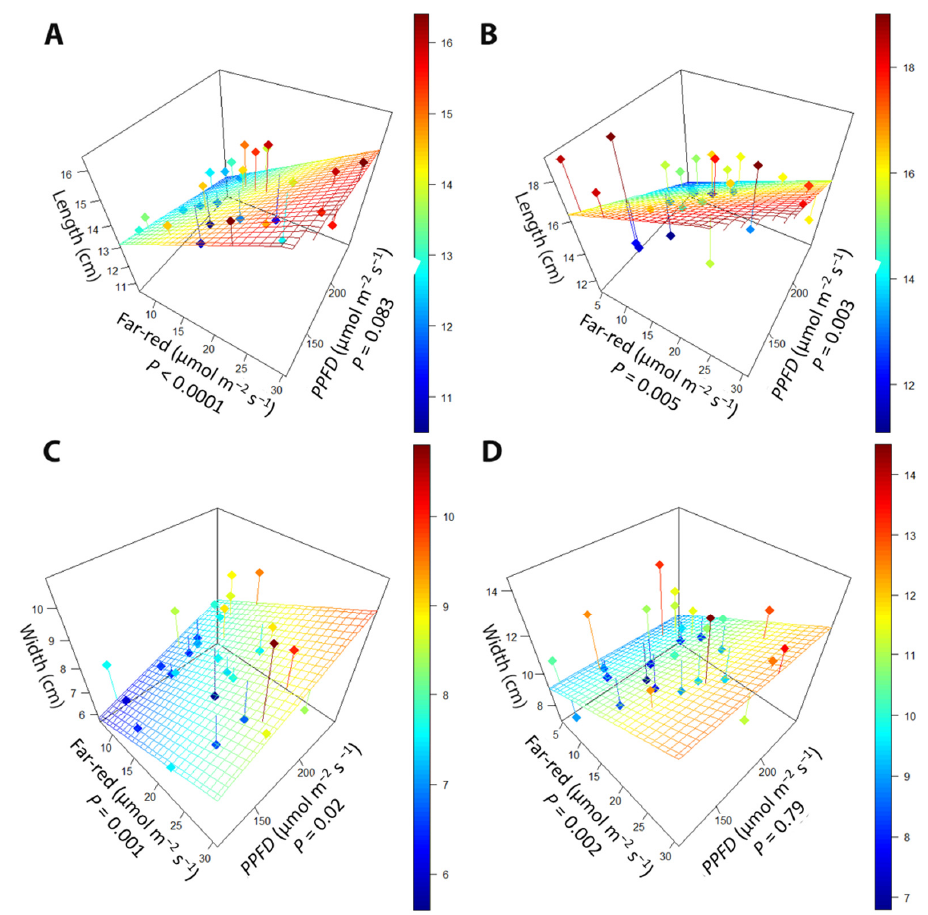
Figure 6. The relationship between supplemental far-red light, photosynthetic photon flux density (PPFD), and ( A ) leaf length at the early harvest, ( B ) leaf length at the late harvest, ( C ) leaf width at the early harvest, and ( D ) leaf width at the late harvest. “Green Salad Bowl” lettuce ( Lactuca sativa ) plants were grown under photosynthetic photon flux densities ranging from 111 to 245 µmol m − 2 s − 1 and a far-red gradient ranging from 4.7–32.8 µmol m − 2 s − 1 . The early harvest occurred 16 days after germination, while the late harvest occurred 25 days after germination.